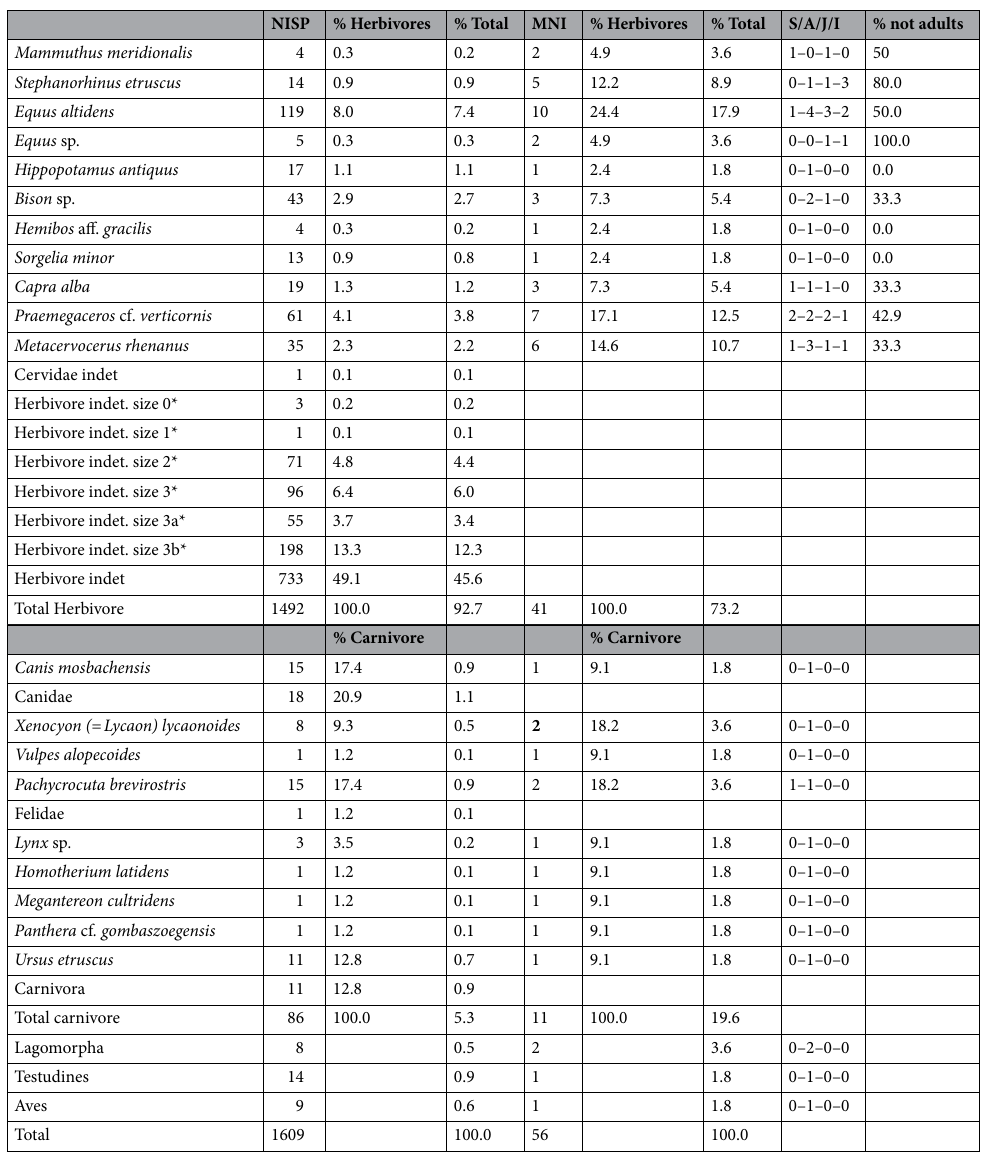
Table 1. List of the Venta Micena 4 remains represented by Number of Identifiable Specimens (NISP) and Minimum Number of Individuals (MNI). Abbreviation for the mortality profiles; S: senile, A: adult, J: juvenile, I: infant. %Total represents all macrovertebrates (both carnivores and herbivores). a See in Supplementary Table S3 for caption of species and relation to animal size. See in Supplementary Table